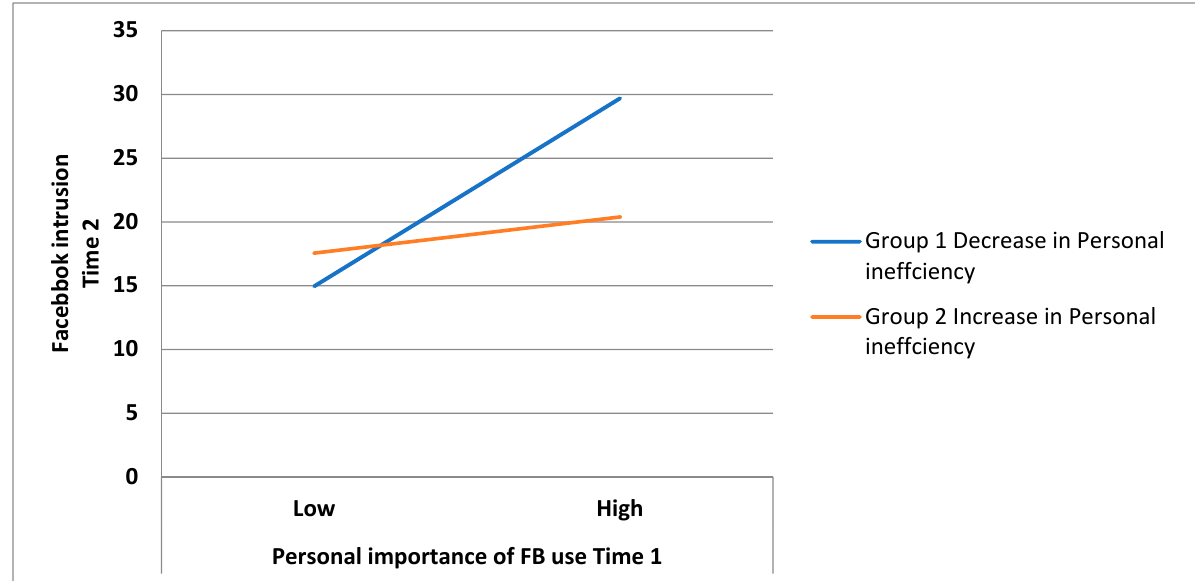
Figure 3. The effects of changes in personal inefficacy on the association between time 1 personal importance of FB use and time 2 FB intrusion.